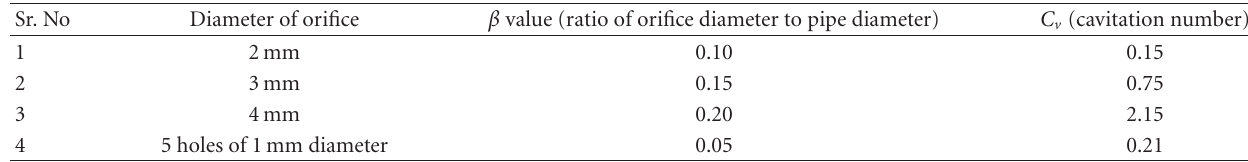
Table 1: Hydrodynamic conditions of di ff erent orifice plate used for experiments.